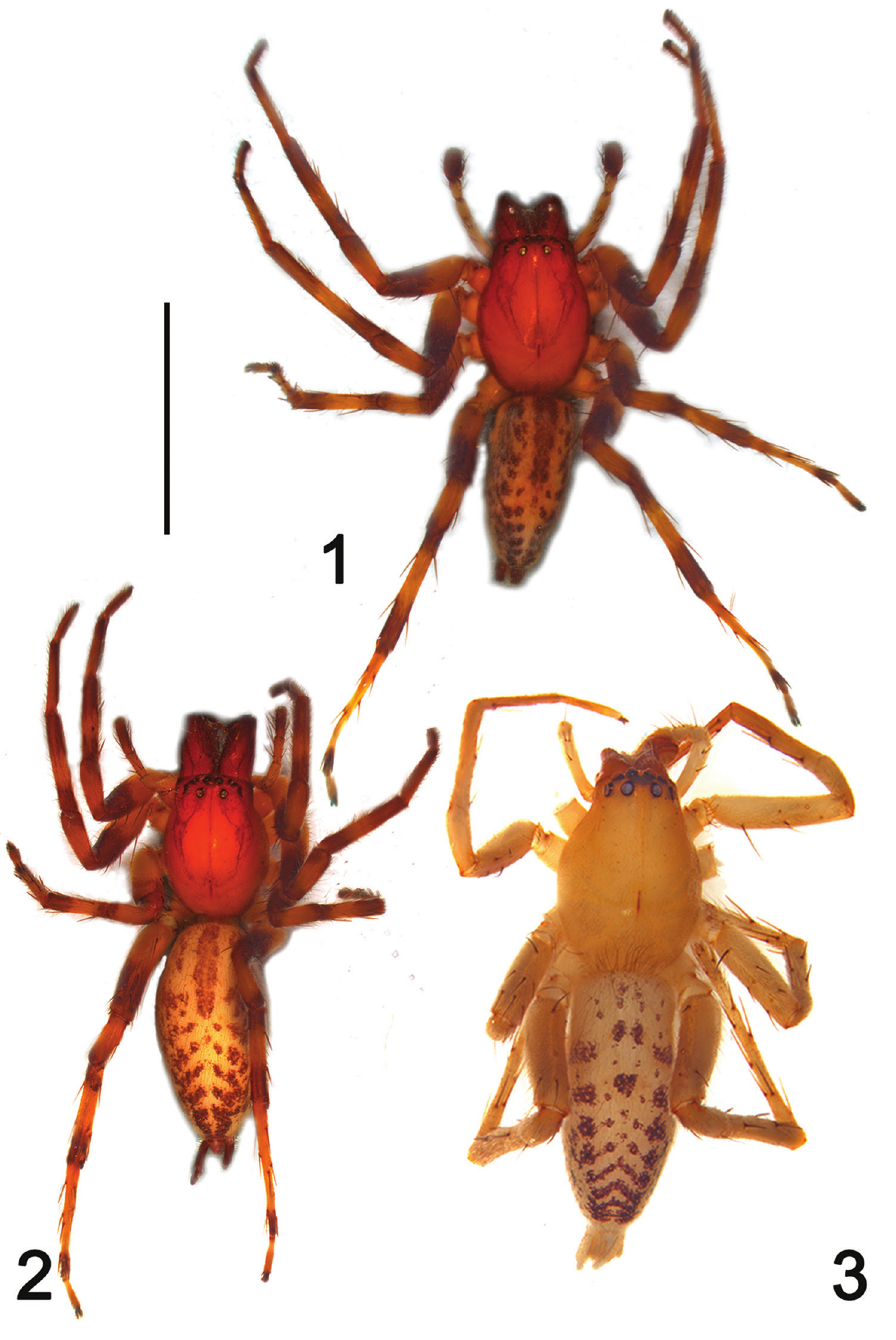
Figures 1–3. Habitus of Clubiona grucollaris sp. n. and C. filicata O. Pickard-Cambridge, 1874, dorsal view. 1 C. grucollaris sp. n., male holotype 2 C. grucollaris sp. n., female paratype 3 C. filicata O. Pickard- Cambridge, 1874, male from Guangxi, China. Scale bars 5 mm ( 1–2 ); 2.5 mm ( 3